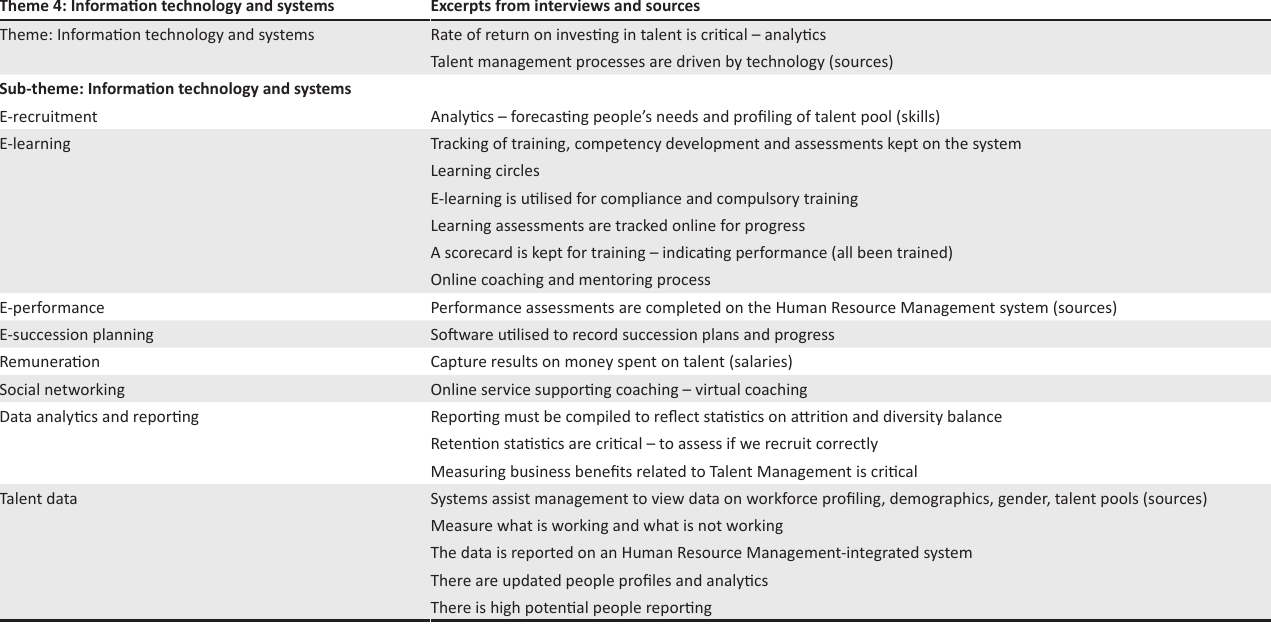
TABLE 5: Organisational climate and